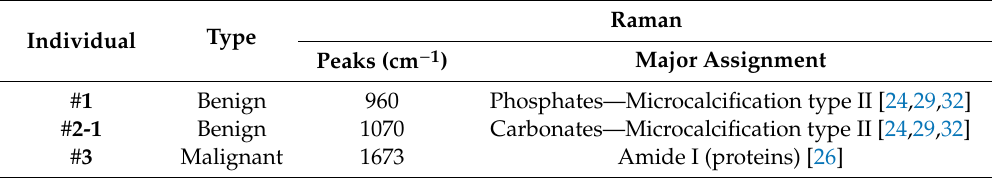
Table 3. Peaks common to the samples of mixed type tumors with bone